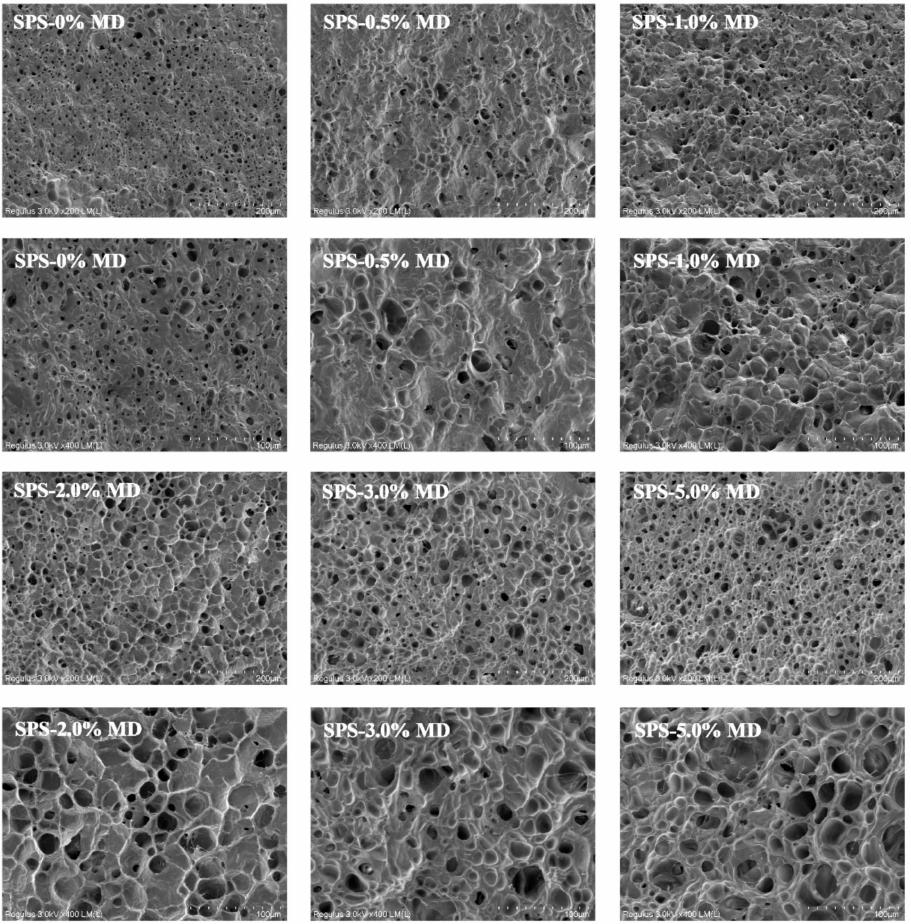
Figure 3. The SEM images of cooked sweet potato starch (SPS) noodles with various (0, 0.5, 1, 2, 3, and 5%, w / w ) maltodextrin (MD)